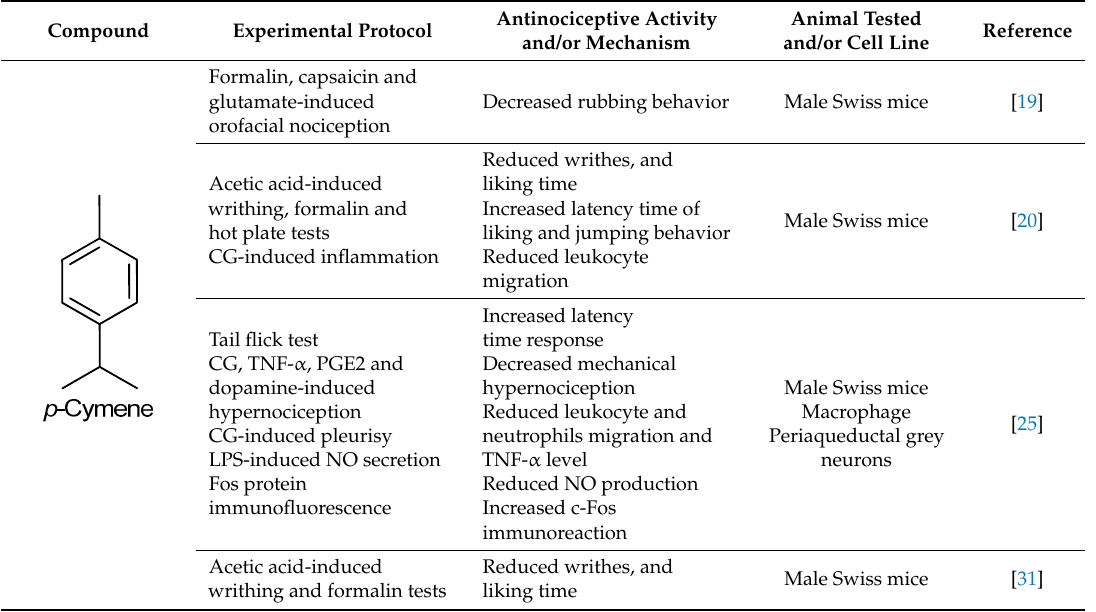
Table 1. Essential oils constituents with antinociceptive activity.